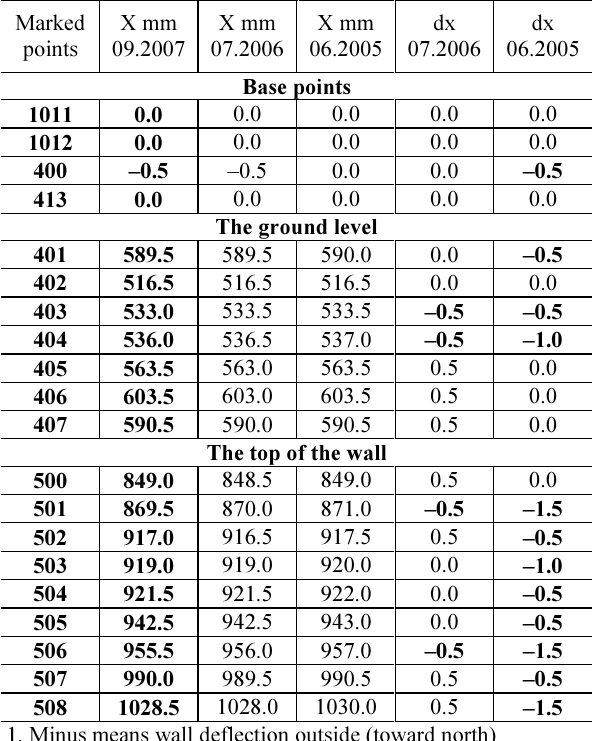
Table 1. Selected horizontal displacements of the northern